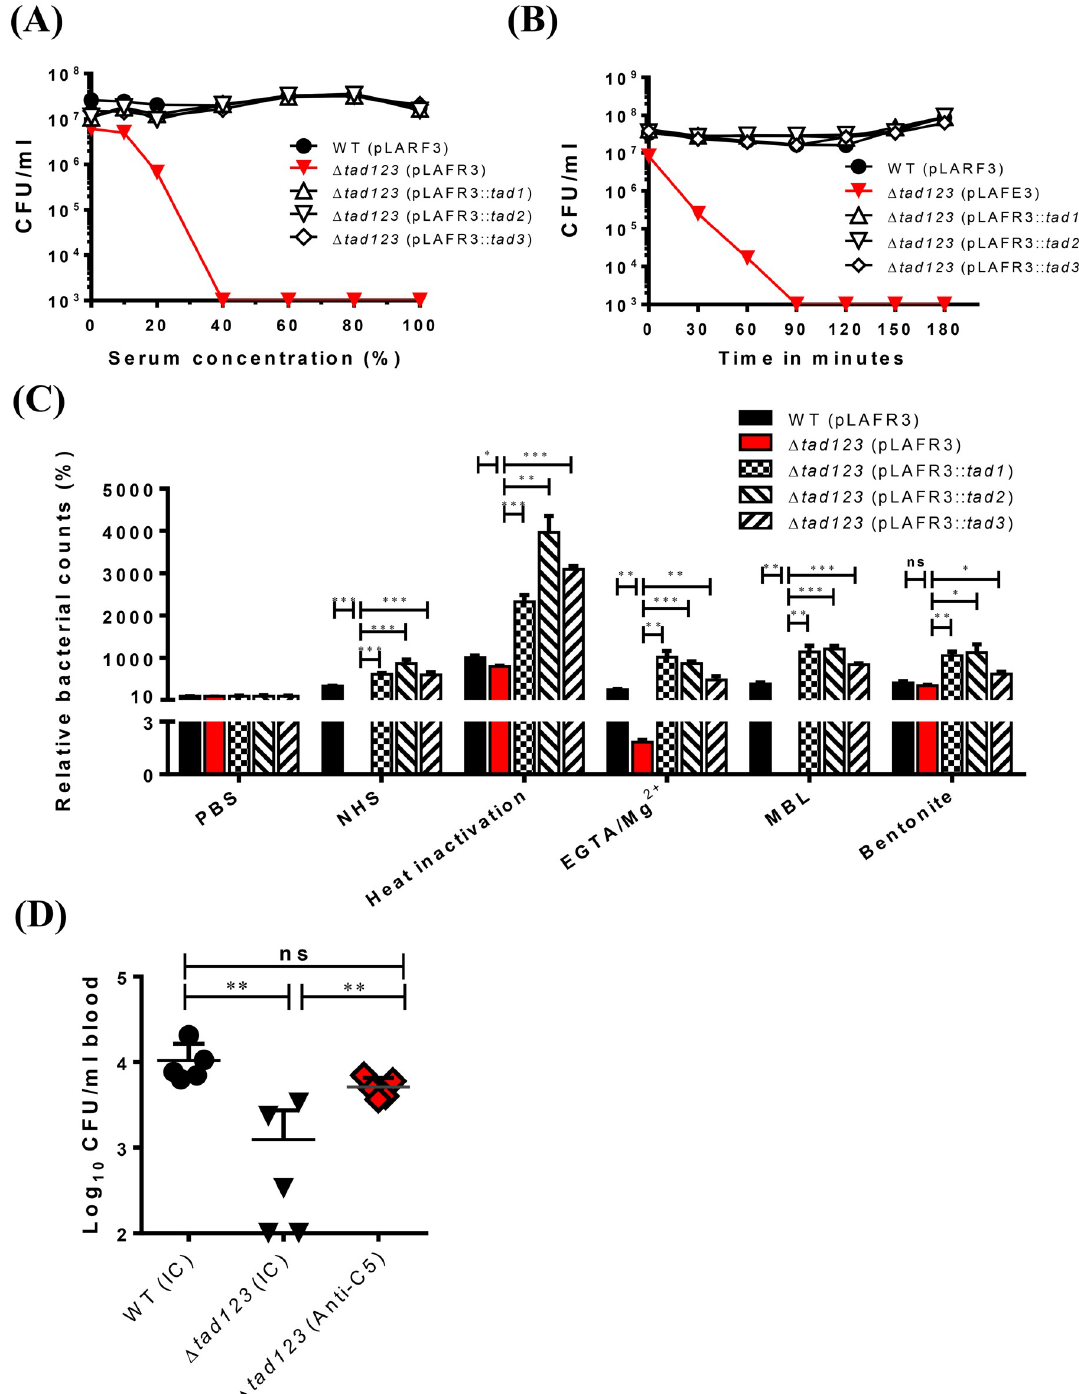
Fig 9. Survival of V . vulnificus against human serum bactericidal killing. (A) Log-phase bacteria grown in the presence of 2 μ g/ml tetracycline were washed with PBS and then incubated with different NHS concentrations at 37 ˚C for 2 h and the numbers of viable cells were determined. (B) Log-phase bacteria grown in the presence of 2 μ g/ml tetracycline were washed with PBS were incubated with 60% NHS and the numbers of viable cell were determined in a time-dependent manner. (C) Log-phase bacteria grown in the presence of 2 μ g/ml tetracycline were washed with PBS were incubated with HIS, undiluted NHS, EGTA/Mg 2+ -treated NHS, MBL-depleted NHS or bentonite-treated NHS for 2 h. Viable bacterial cells were counted by plating on 2.5% NaCl HI agar plates. Bacteria were incubated in PBS as a control. WT (pLAFR3), wild type harboring pLAFR3; Δ tad123 (pLAFR3), Δ tad123 mutant harboring pLAFR3; Δ tad123